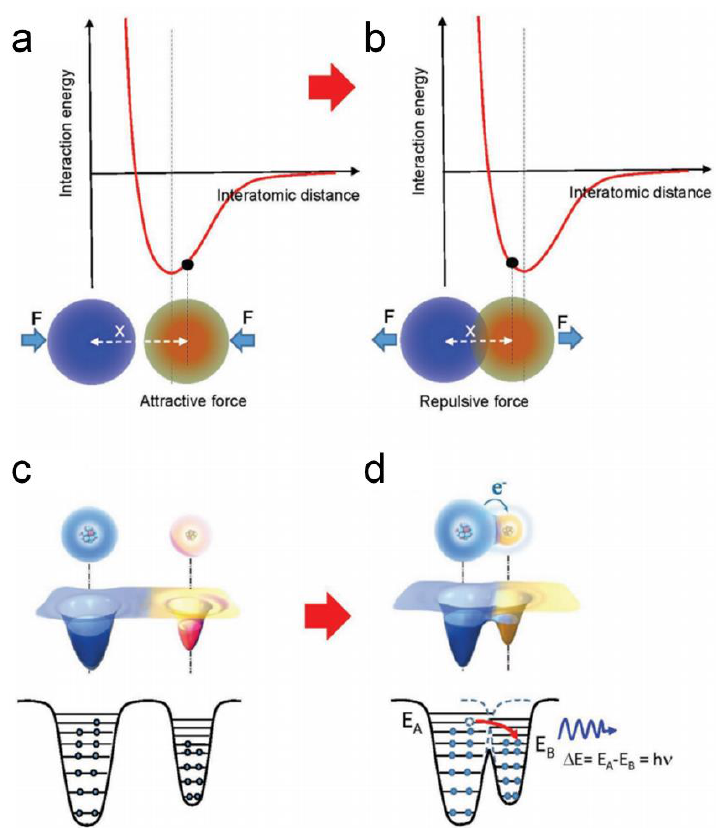
Figure 5. The overlapped electron-cloud model proposed for explaining contact electrification (CE) and charge transfer between two atoms for a general case. ( a , b ) Interatomic interaction potential between two atoms when the force between the two is attractive and repulsive, respectively, by applying an external compressive force. Experiments found that electron transfer occurs only when the two atoms are in the repulsive interaction—for example, in the case when the two atoms have strong electron-cloud overlap. ( c , d ) Schematic of the electron cloud and potential energy well model of two atoms belonging to two materials A and B when they are separated and in close contact, respectively. Electron transition from atom A to atom B is possible due to the lowered potential barrier